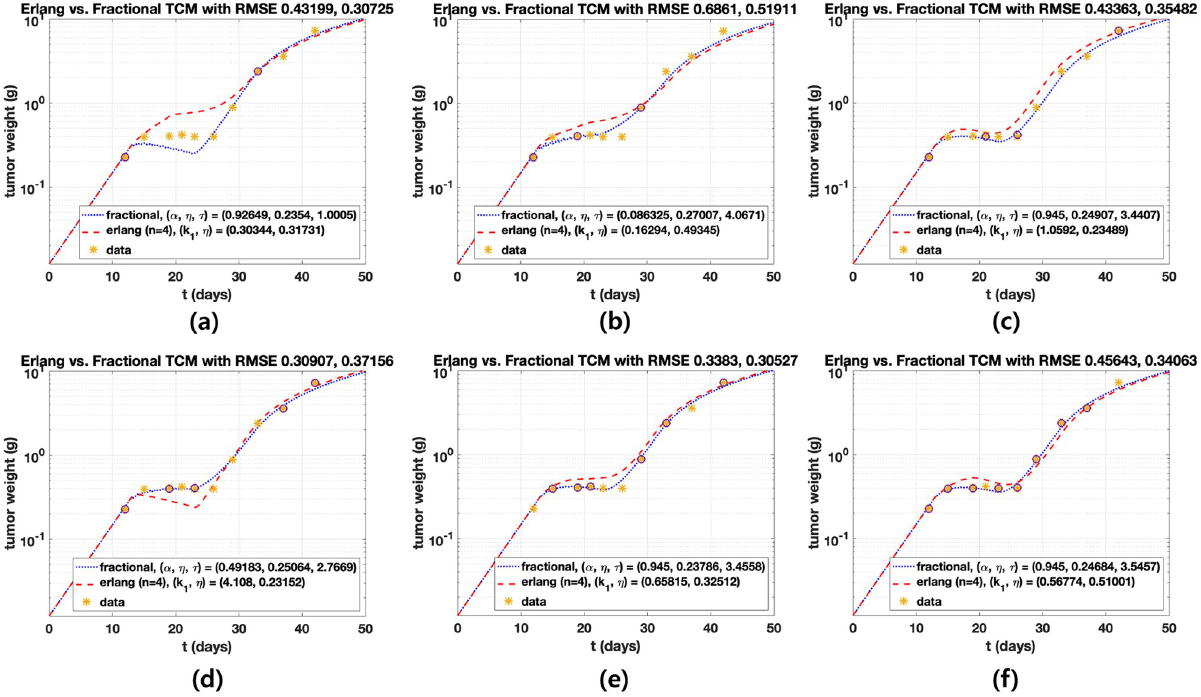
Fig 5. Parameter estimations are conducted according to the amount of data. log-scale about y axis is used. The circle represents test data (Points 2, 3, 4, 5, 6, 8) and the star shapes represent full data (ten points). The number of compartments is four in Erlang TCM, except for the compartment of proliferating cells. Samples are randomly selected among full data once the amount of data was selected. (a) Both models fail to predict full data. (b) Both TCMs accurately fit the data; however, Erlang TCM exhibits less suppression of tumor during treatment in this dataset. (c), (e), (f) Both models accurately fit the data. In (d), Erlang TCM exhibits stronger tumor suppression during treatment in this dataset but data fit quality is unreliable.